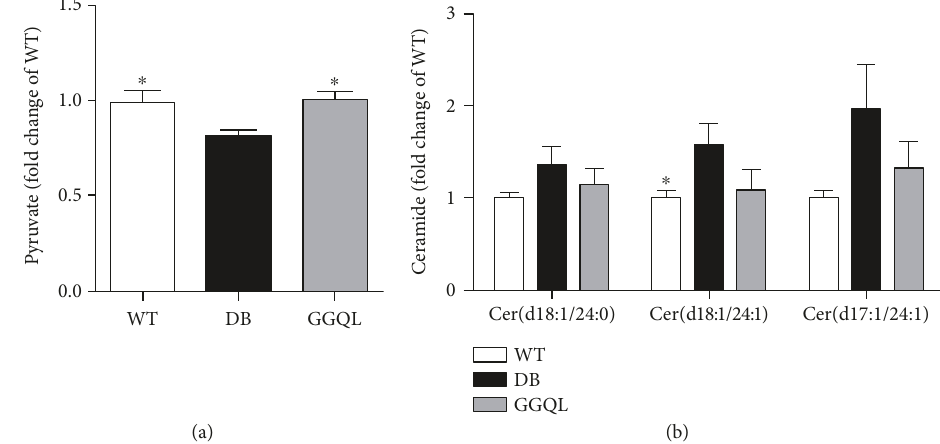
Figure 5: The results of pyruvate and ceramide content in the myocardial tissue. The content of (a) pyruvate and (b) ceramide in each group ( n = 3 – 6 ). The DB group was the reference group to calculate P values, ∗ P < 0 05